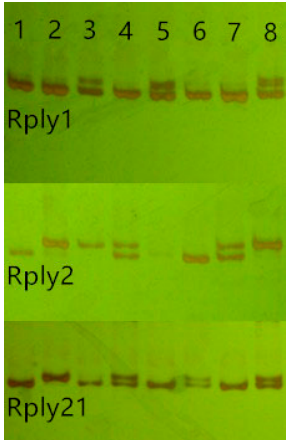
Figure 2. Amplification results at the single-sequence repeat loci Rply1, Rply2, and Rply21 using eight cultivars of black locust. (PCR products were separated by electrophoresis in 8% non-denaturing polyacrylamide gel and fragments were detected by silver staining.). Table 2. Characteristics of 25 polymorphic, repeatable and stable simple sequence repeat (SSR) markers derived from expressed sequence tag (EST) of Robinia pseudoacacia L. (Na: Number of observed alleles).